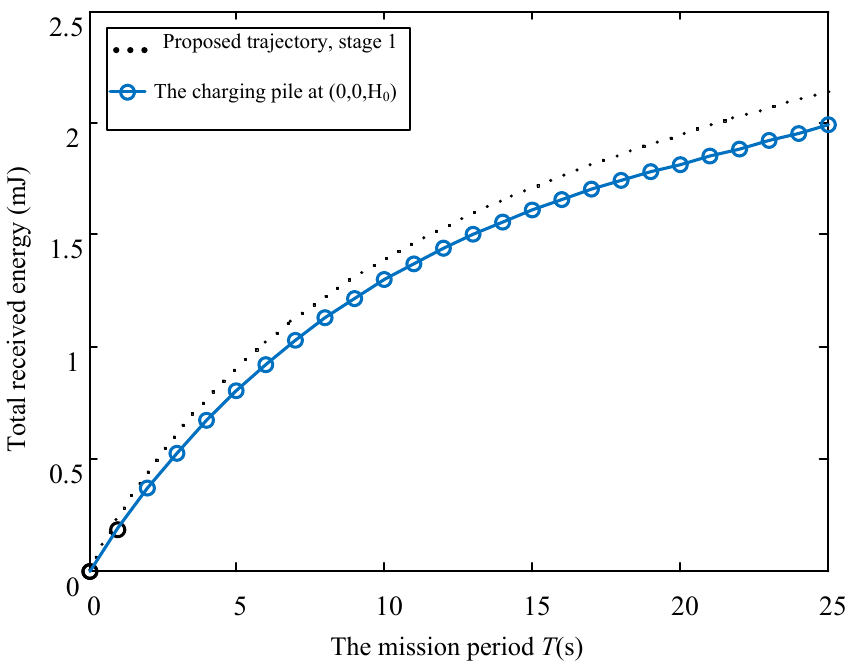
Figure 6. The relationship between total received energy and mission period T with V = 0.2.